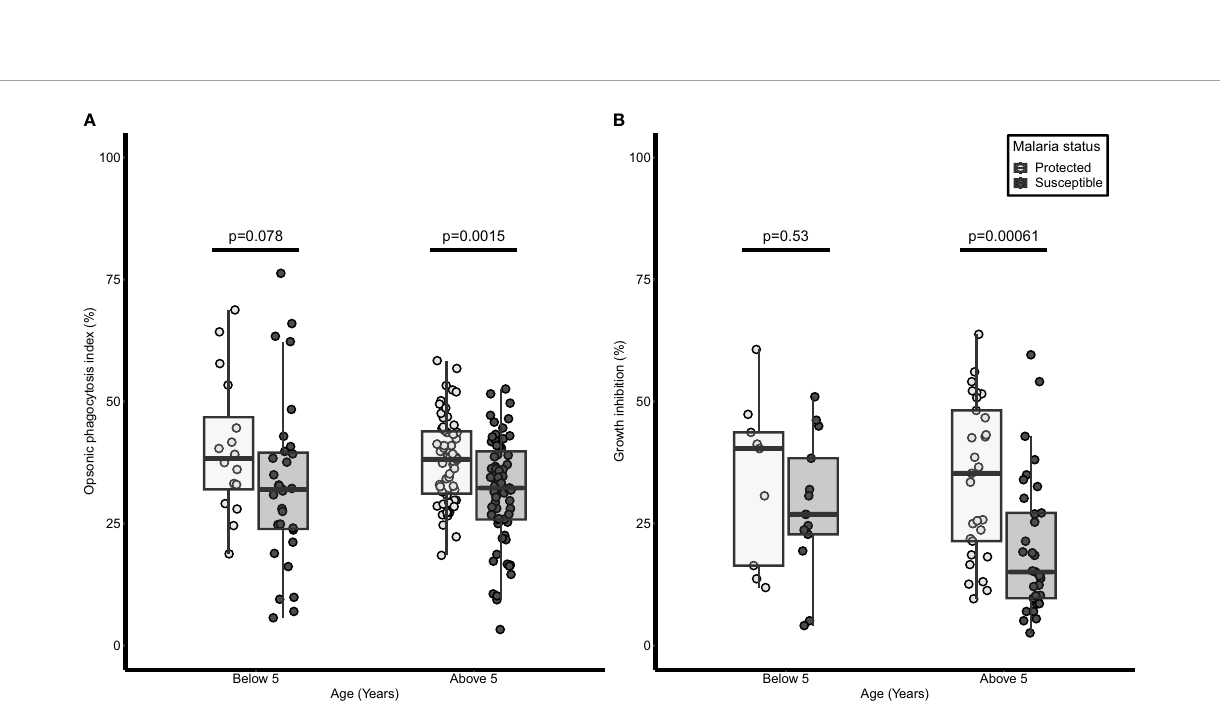
FIGURE 2 Opsonic phagocytosis and growth inhibition activities are higher in older children and are associated with protection against malaria. A dot and box plot of: (A) opsonic phagocytosis activity (n=238), (B) growth inhibition activity (n=84); for children below 5 years and those above 5 years we were protected from or susceptible to malaria. The lighter dots and box represent protected children while the darker dots and box represent susceptible children. The horizontal line within each box denotes the median of the distribution, the upper and lower borders of the box denote the upper and lower quartiles respectively. The upper and the lower whiskers indicate the maximum and minimum OP values respectively. P values were derived from the Mann Whitney U